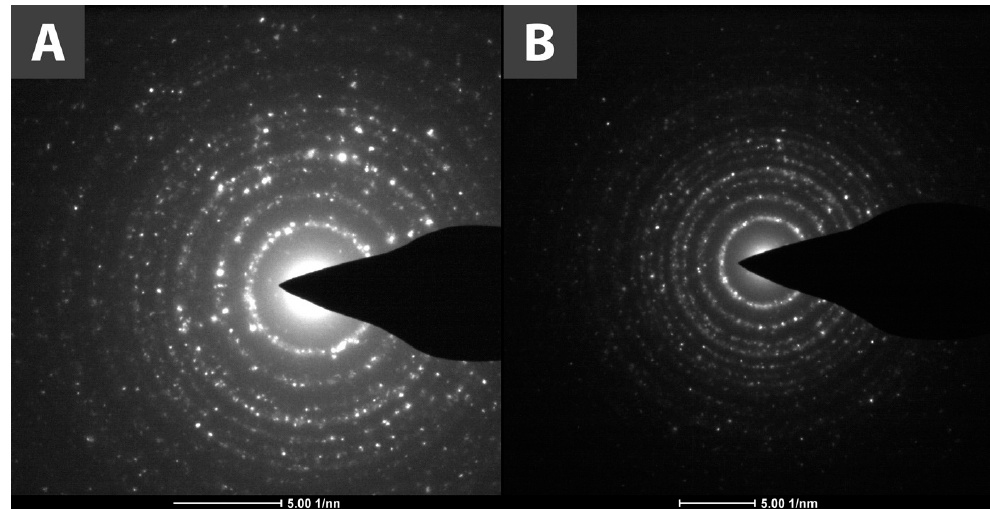
Figure 3. SAED patterns of ( A ) TiO 2 and ( B ) TiO 2 -GA. Table 3. Nanoparticle size measurements with NTA and BET surface area.